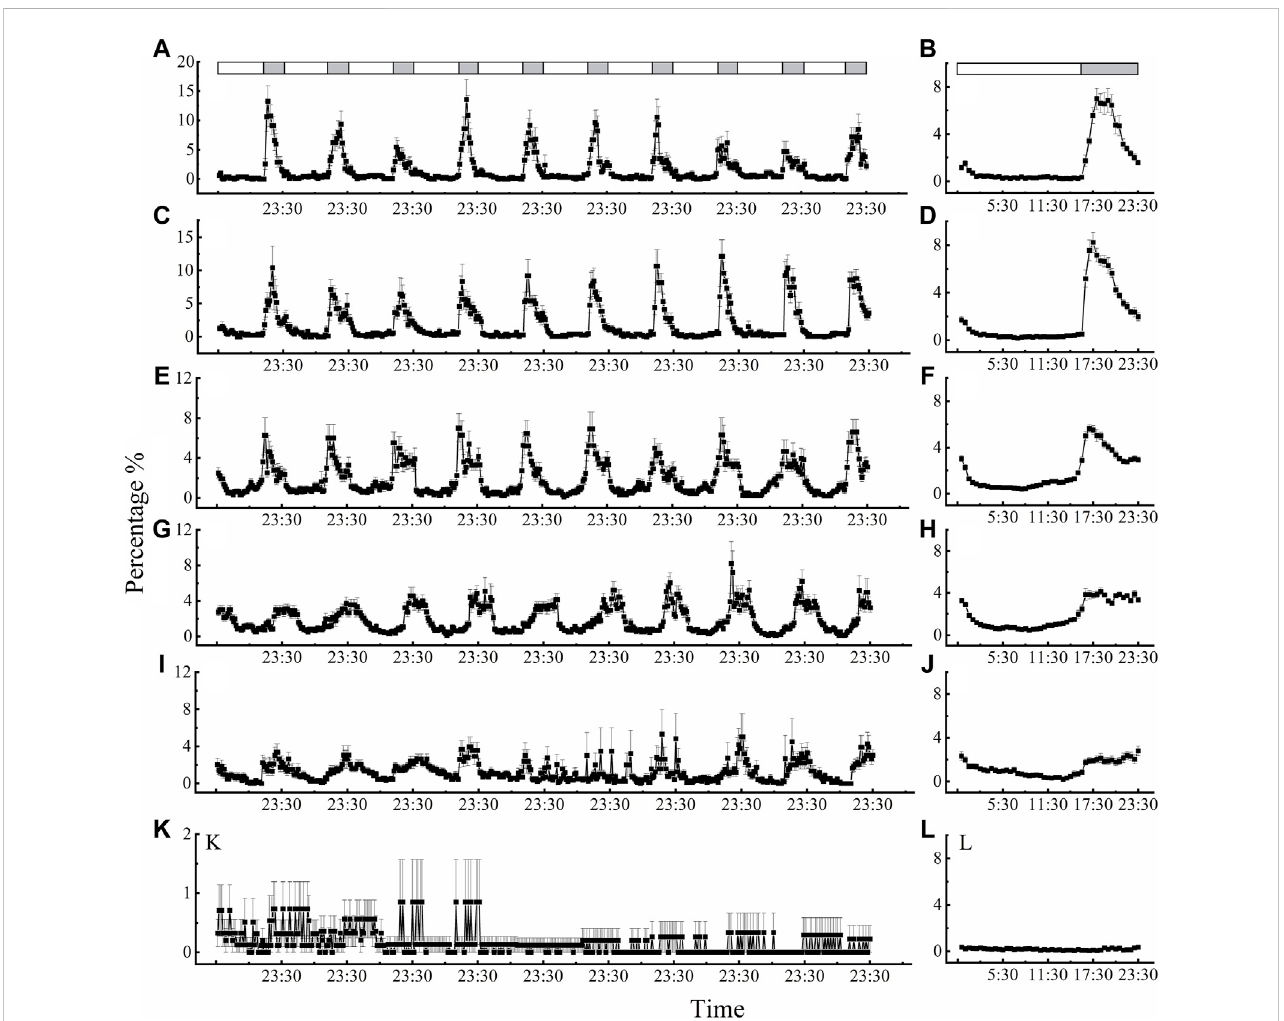
Figure 3 Circadian rhythms of locomotor activity of D. helophoroides at different temperatures. (A, B) 15 ° C; (C, D) 20 ° C; (E, F) 25 ° C; (G, H) 30 ° C; (I, J) 35 ° C; (K, L) 40 ° C.Data(n=20)shownarethemean±SEM.Thepercentagesindicatetheoccurrencefrequencyofsinglebehaviorsofindividualtestinsectsinvarioustime intervals within 1 day. The light-dark cycle was 16 h L/8 h D. Black and white bars represent the LD cycle, black = subject night, white = subject